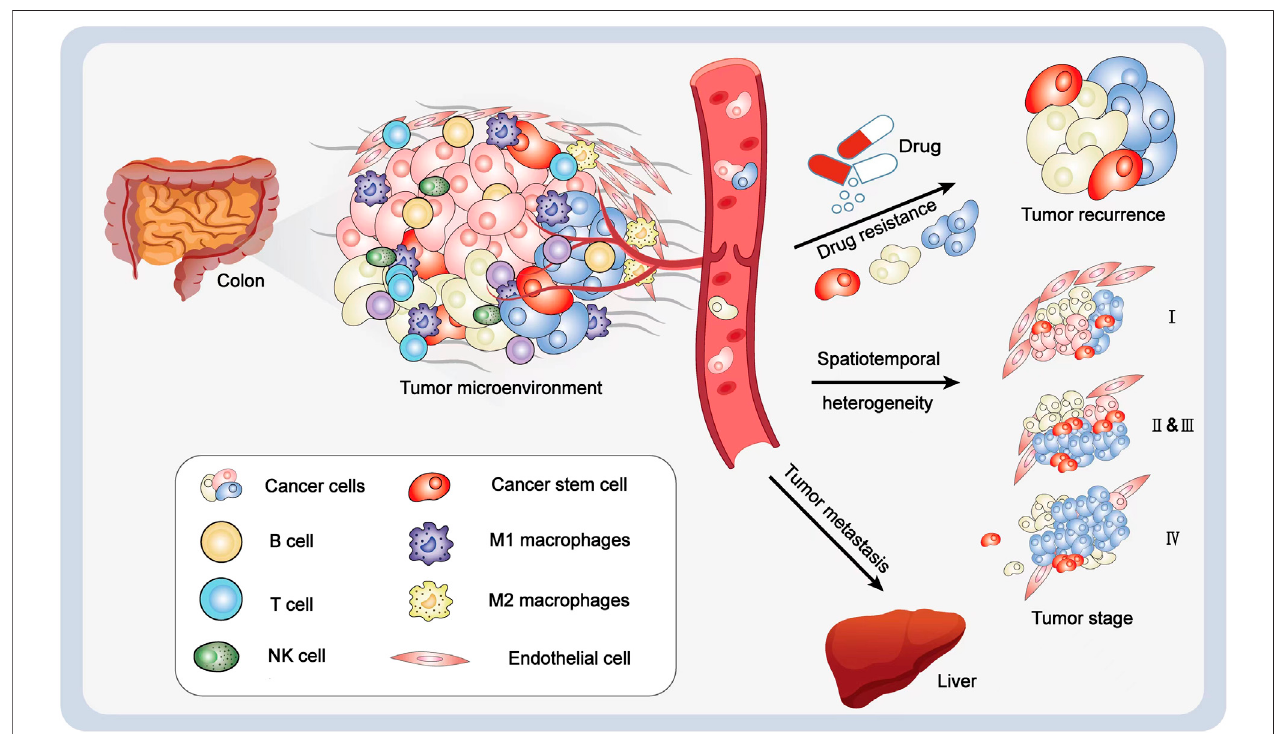
FIGURE1| Illustrationoftheheterogeneityofatumor.Cancercells,immunecells,andstromalcellsarethemajorcomponentsofatumor.Theinteractionbetween microenvironment and different tumor cells makes cancer cells possess different growth potential and proliferation abilities. Cancer stem cells are the source of tumor occurrence. In the process of treatment, although most cancer cells can be eliminated through chemotherapy, drug treatment, or surgery, they can still relapse or metastasize through blood vessels and produce drug resistance. Additionally, the temporal and spatial heterogeneity of tumors will also lead to the differences in tumor treatment schemes and treatment ef fi cacies at different